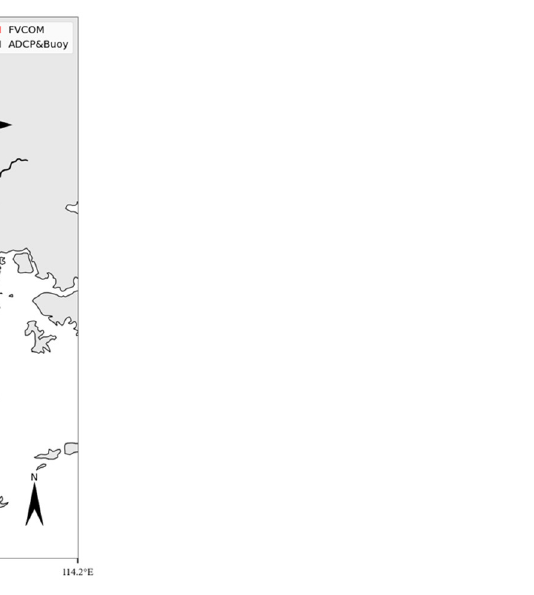
Figure 3. Comparisons of monthly averaged velocities (cm/s, vector) from mooring observation and the model.